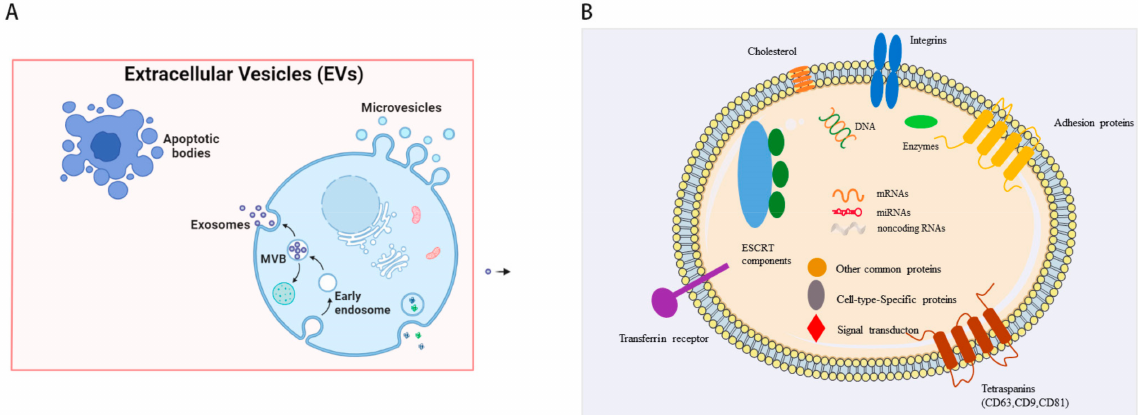
Figure 1. Biogenesis of EVs and schematic of exosomal molecular compositions. ( A ). EVs contain apoptotic bodies, microvesicles, and exosomes. Apoptotic bodies are formed by membrane folding, invagination, and shedding with organelles and nuclear debris. MVs are formed by the direct outward budding of plasma membranes. As for exosomes, at the very beginning, the invagination of the plasma membrane forms a cup-shaped structure termed early endosome containing cell surface proteins and other biological substances. Early endosomes then develop into late endosomes, which invaginate to form multivesicular bodies (MVBs) that finally fuse with the plasma membrane and release the exosomes. ( B ). Exosome contains various important biomarkers, such as proteins, lipids, and